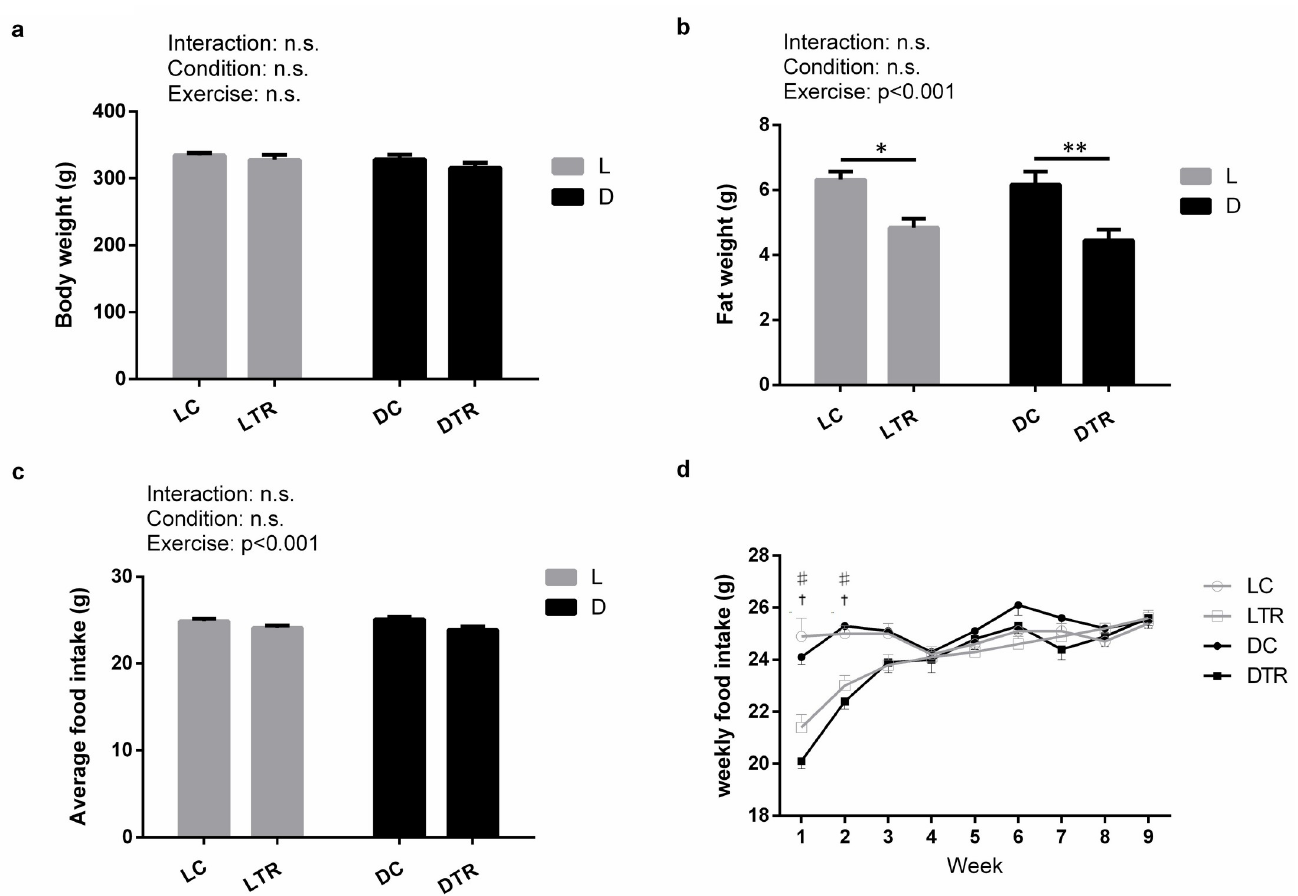
Fig 1. Body weight, fat weight, and food intake. Body weight (a), fat weight (epididymal white adipose tissue) (b), average food intake (c), and weekly food intake (each value represents the mean of 6 days) (d). L, light phase; D, dark phase; C, control; TR, trained group. Values are the mean ± standard error (SE); n = 6 per group. The results of the two-way analysis of variance (ANOVA) are displayed in a, b, c; � P < 0.05, �� P < 0.01. The results of the one-way analysis of variance (ANOVA) are displayed in d; ✝ LC versus LTR, P < 0.05; ] DC versus DTR, P < 0.05.